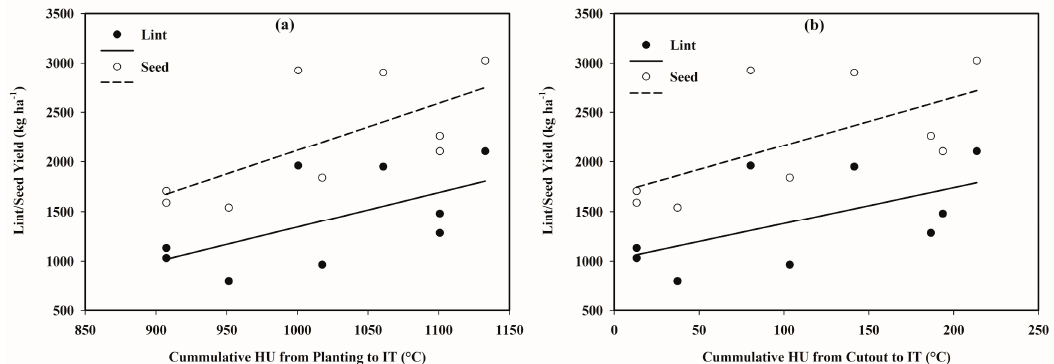
Figure 2. Yield response to accumulated heat units from ( a ) Planting to IT and ( b ) Cutout to IT.